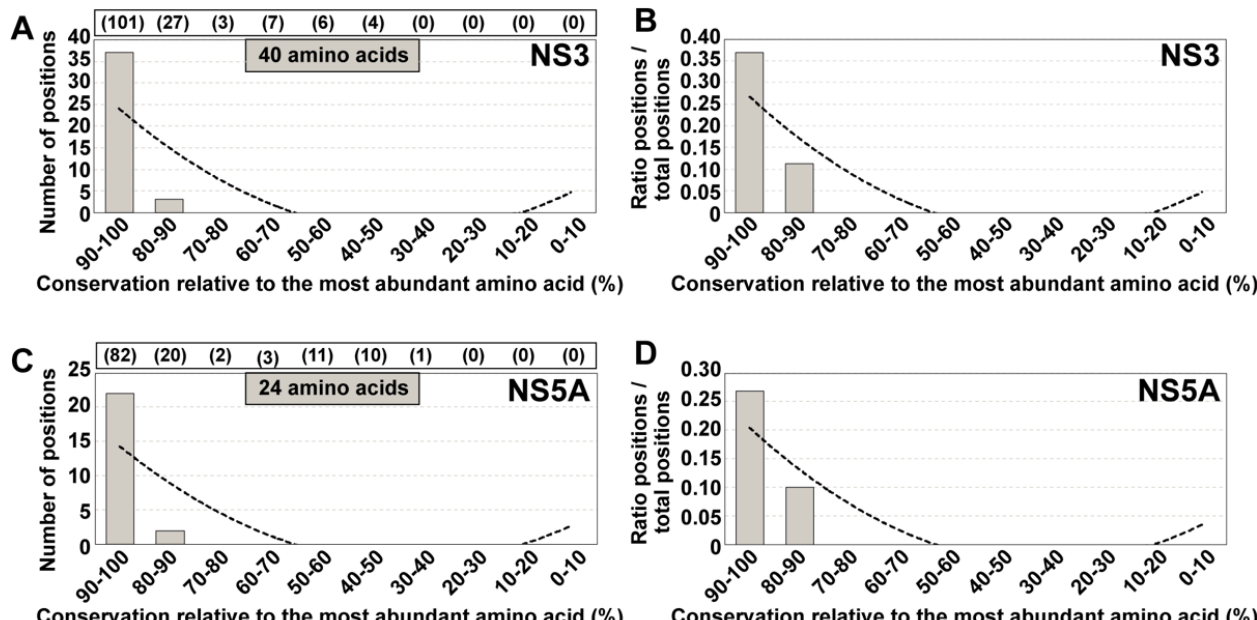
Figure 5. Distribution of conserved positions—identified by aligning the HCV mutant spectra from infected patients— among the amino acid conservation groups according to the LANL amino acid sequence alignment. ( A ) Assignment of the 40 strictly conserved amino acids patients’ quasispecies to conservation groups calculated from the LANL alignment. The residues under study span amino acid 32 to amino acid 179 of protein NS3. Conservation groups are indicated in abscissa, and the number of positions that fall into each group is indicated in ordinate. The total number of amino acids that fall in each conservation category in the LANL alignment is indicated in parentheses in the upper box. The discontinuous line corresponds to y = 0.8636x 2 − 11.645x + 34.8 (R 2 = 0.6351). ( B ) same as ( A ), but with values normalized to the total number of amino acids that fall within each conservation group. The defining function is y = 0.0092x 2 − 0.1255x + 0.3853 (R 2 = 0.7652); ( C , D ) same as ( A , B ) but with the 24 strictly conserved amino acids comprised between amino acid 24 and 152 of protein NS5A. The defining functions are: ( C ): y = 0.5152x 2 − 6.9515x + 20.8 (R 2 = 0.642); ( D ): y = 0.0069x 2 − 0.0943x + 0.2915 (R 2 = 0.7923). The complete list of those amino acids that are strictly conserved in the HCV-infected patients is given in Table